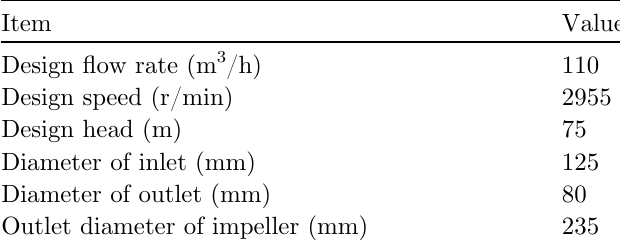
Table 1. Main parameters of the centrifugal